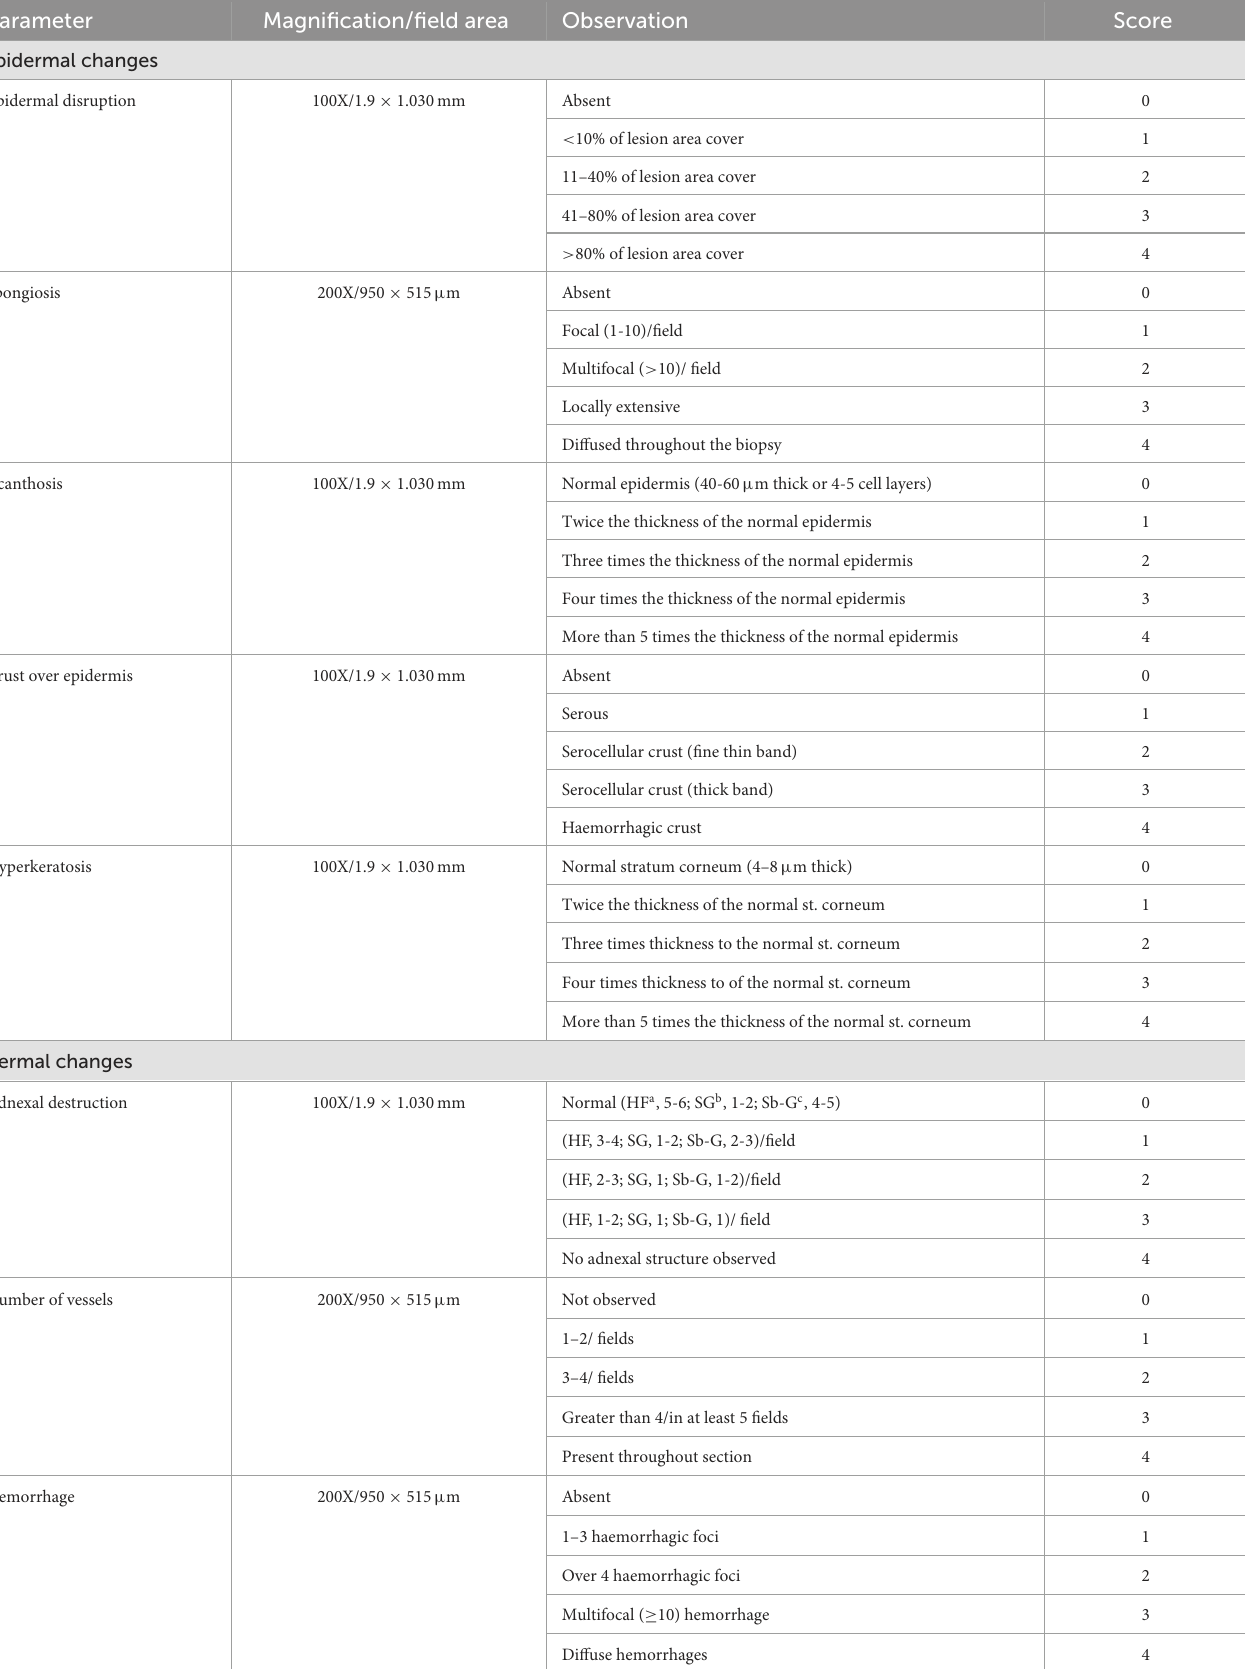
TABLE 2 Grading scales for scoring histological changes in buffalo fly